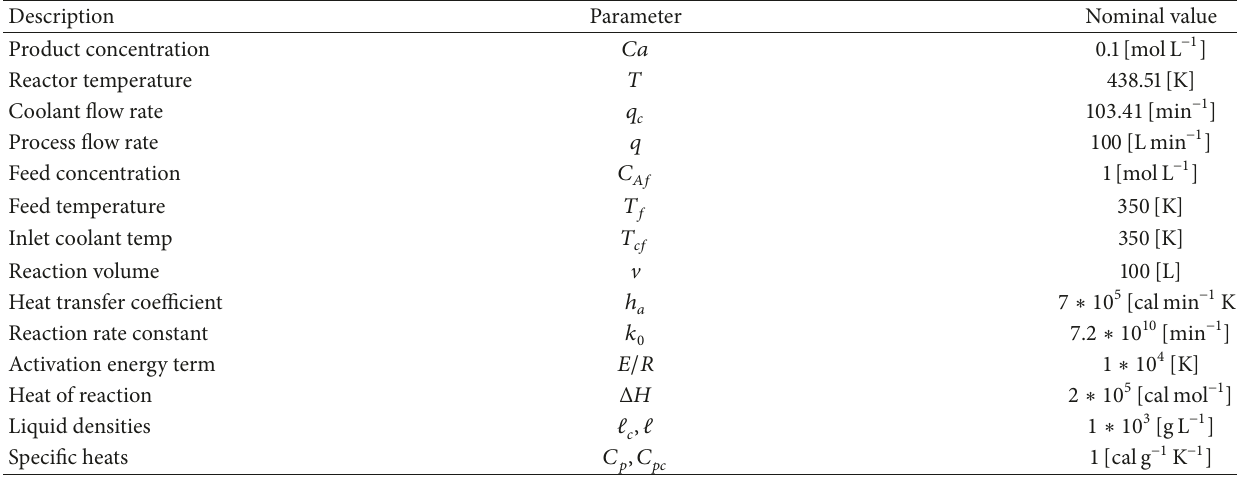
Table 4: CSTR model